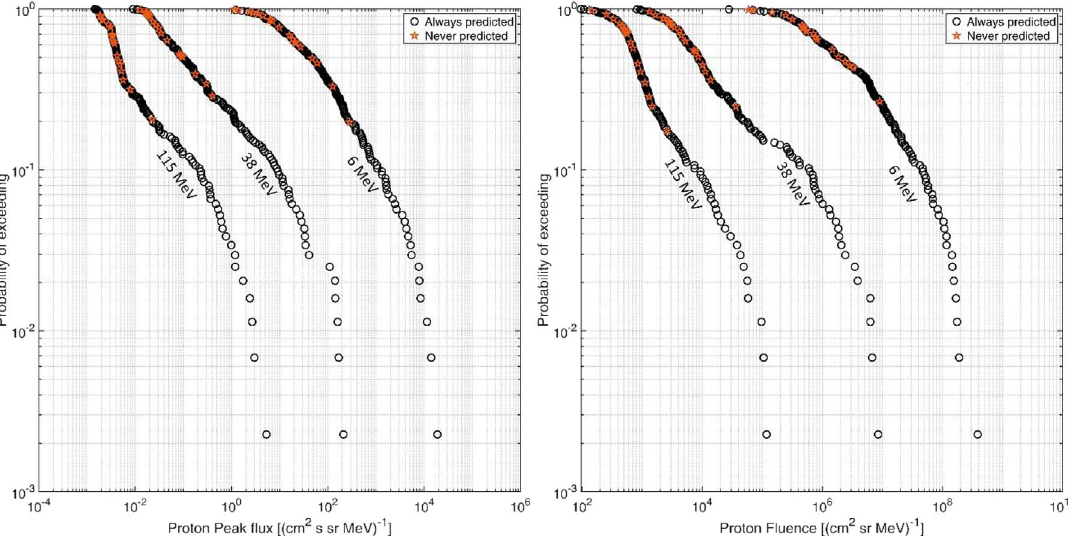
Fig. 8. Experimental cumulative distributions of the Peak Fluxes and Fluences of the SEP proton components at 6 MeV, 38 MeV, and 115 MeV. Events always predicted are in black circles, and the never predicted are in orange stars.